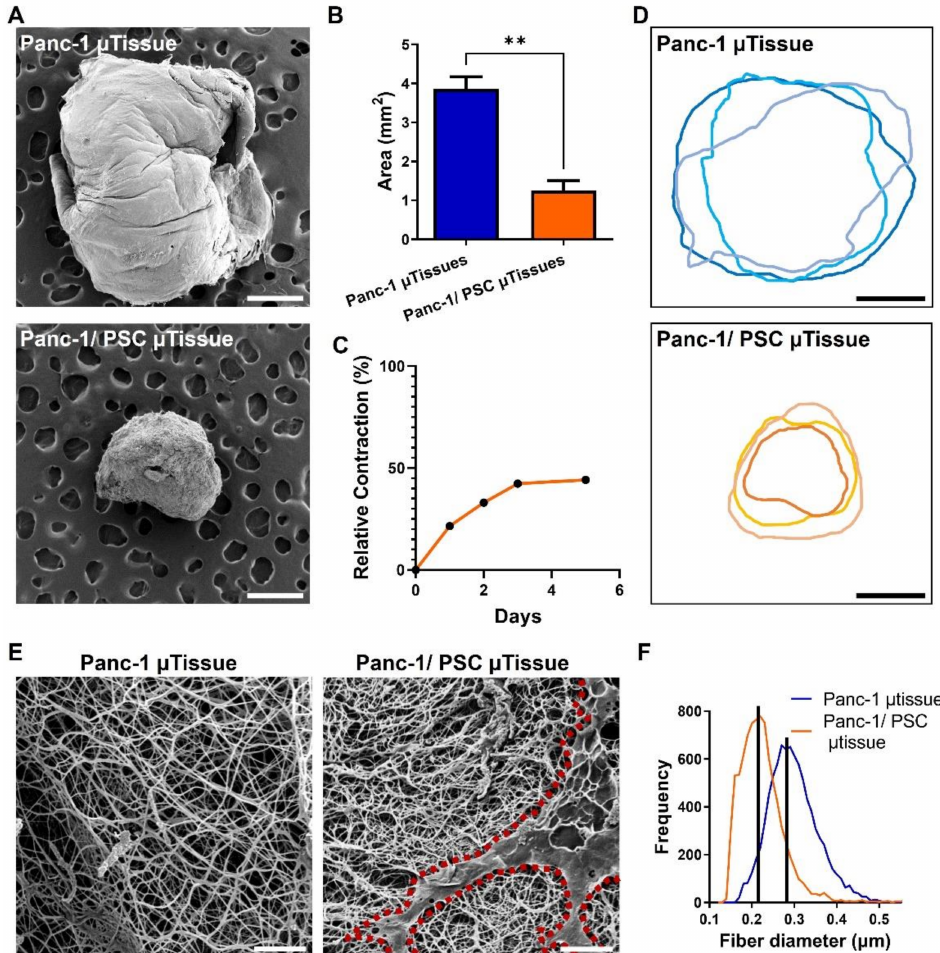
Figure 2. PSC-mediated contraction of PDAC µ tissues. ( A ) Scanning electron microscopy (SEM) images for Panc-1 µ tissues (top) and Panc-1/PSC µ tissues (bottom) (scale bar = 500 µ m). ( B ) Quan- tification of the µ tissue size based on SEM images. ( C ) Relative contraction of Panc-1/PSC µ tissues for a culture duration of 5 days. ( D ) Individual outlines for 3 individual Panc-1 µ tissues (top) and Panc-1/PSC µ tissues (bottom) (scale bar = 500 µ m). ( E ) SEM images of the surface structure of Panc-1 µ tissues (left) and Panc-1/PSC µ tissues (right). Red outline highlighting PSC on the surface of hydrogel (scale bar = 10 µ m). ( F ) Quantification of the fiber diameter based on SEM images. Data represent mean ± standard error of the mean for at least 3 independent experiments. Statistical analysis was performed by two-tailed Student’s t -test. ** p <